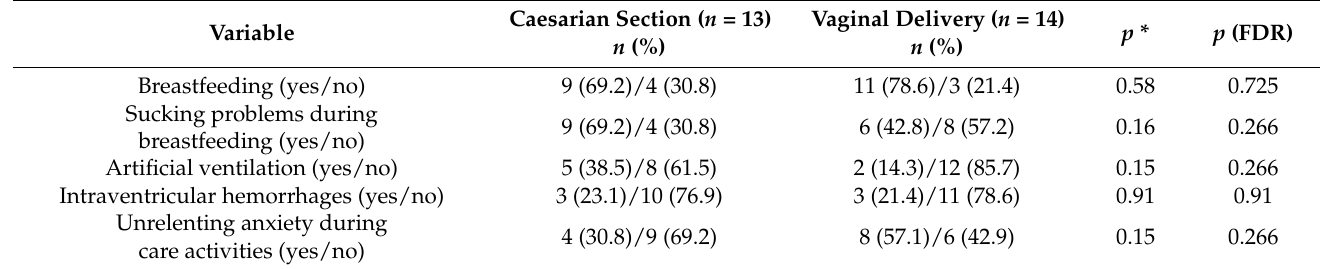
Table 1. Characteristics of the study group ( n =